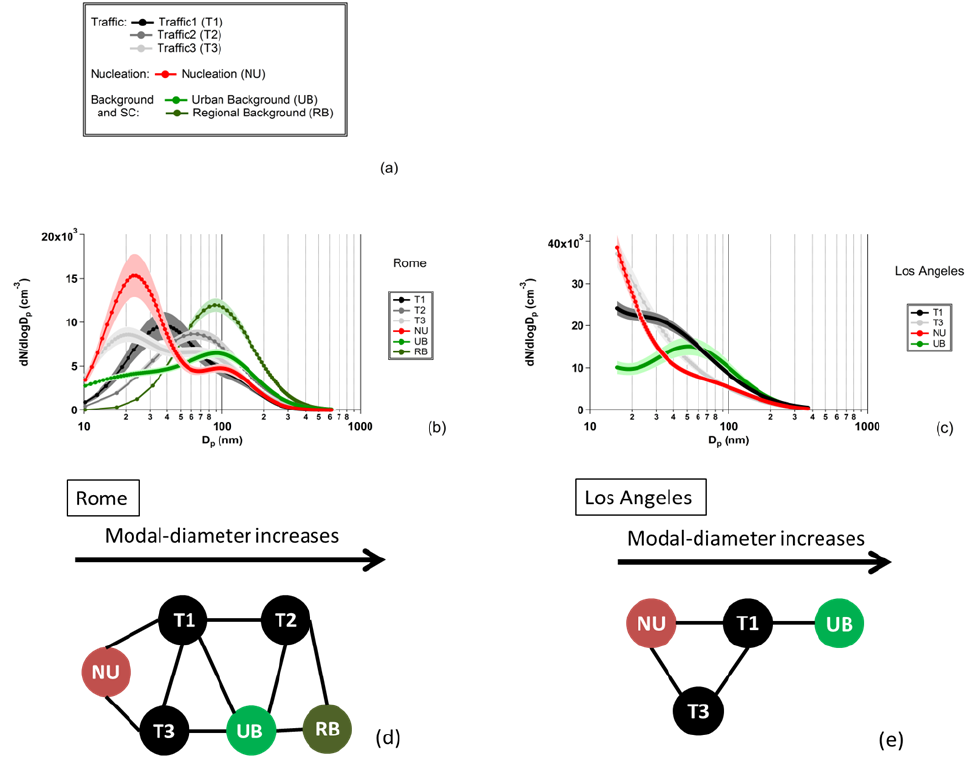
Figure 3. Aerosol size distribution results of the k -means cluster analysis performed on the SMPS data at the selected complementary cities: (a) legend, (b) Rome and (c) Los Angeles. Shaded areas around the curves represent the confidence limits calculated for 3 σ . Please note the different scales for d N / dlog D p . Cluster proximity diagrams are shown for both cities: (d) Rome and (e) Los